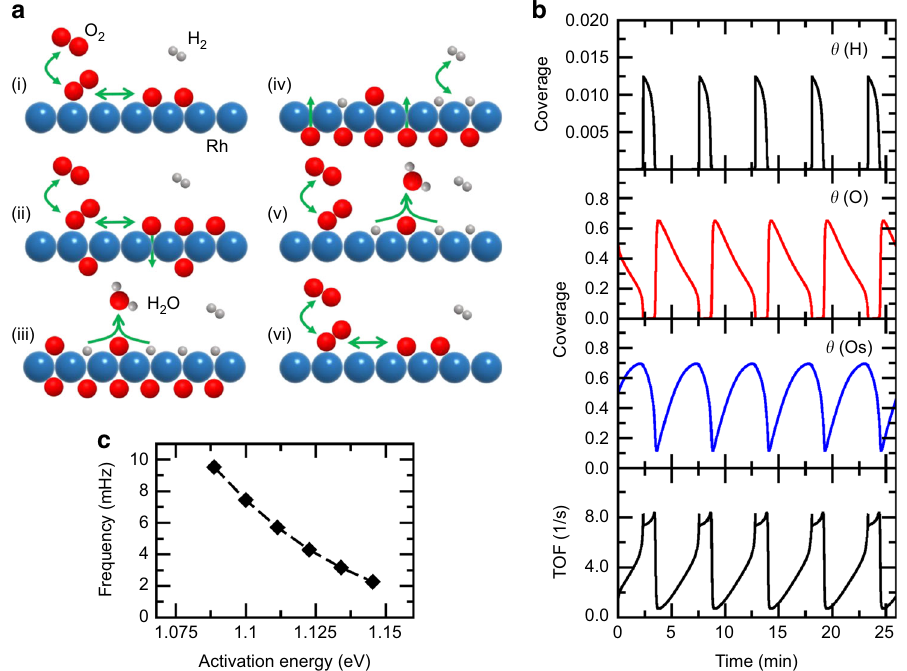
Fig. 3 Reaction steps and micro-kinetic model calculations. ( a ) Schematic representation of the reaction steps in H 2 oxidation on Rh. Color code: Rh (blue), O (red), and H (gray). ( b ) Top to bottom panels show the coverage of hydrogen (H), of oxygen (O), of subsurface oxygen (Os) and the reaction rate. ( c ) Oscillation frequency as a function of the activation energy for oxide formation. The simulations have been performed at T = 433 K and partial pressures of oxygen and hydrogen of 1.1 × 10 − 6 mbar and 8.4 × 10 − 7 mbar, respectively